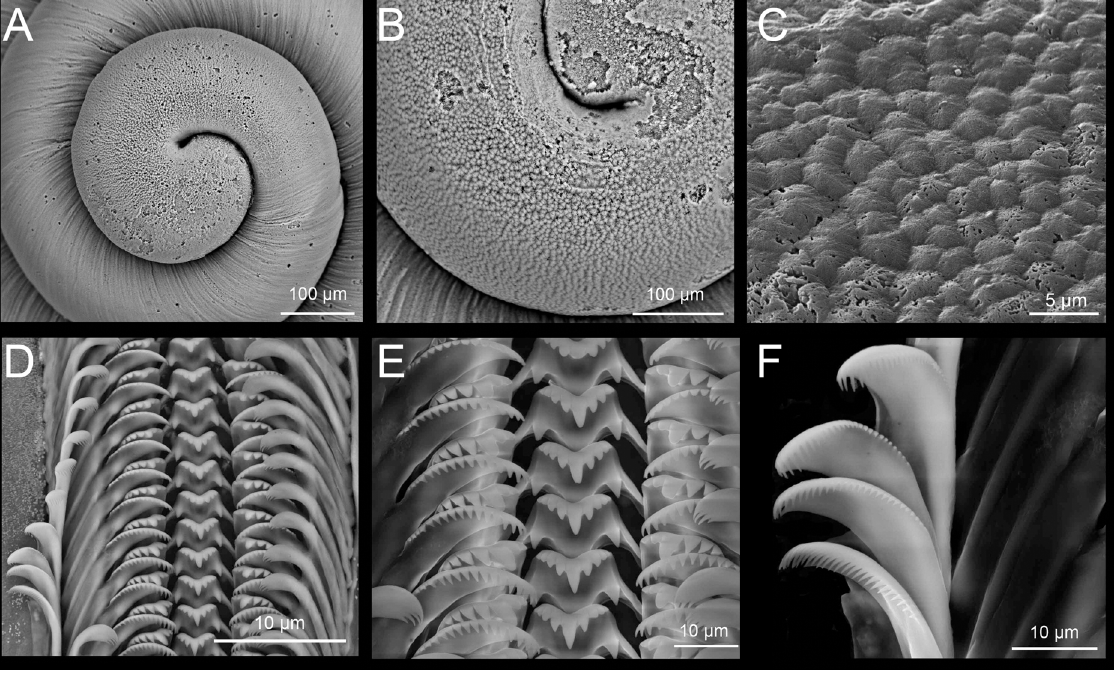
Fig. 21 . Protoconch and radula of Mercuria carrillorum Miller, García-Guerrero & Ramos sp. nov.